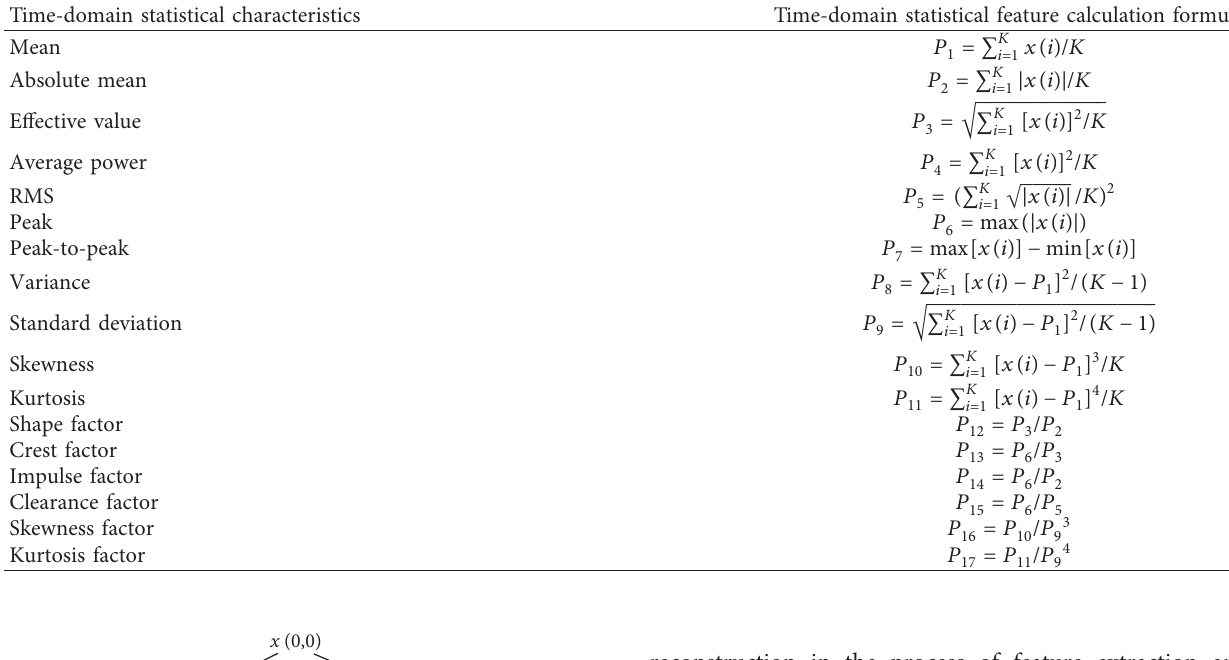
Table 2: Time-domain feature extraction method.